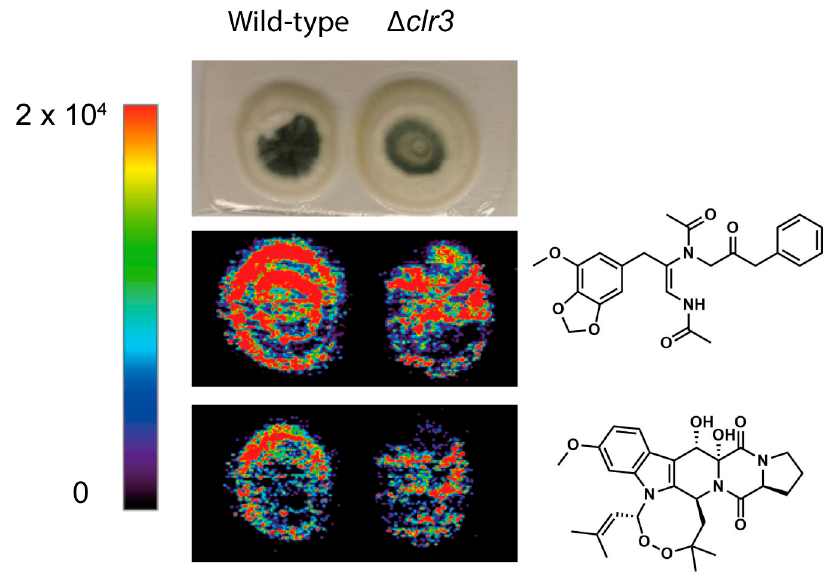
Figure 9. (+) DESI-MSI showing different spatial distributions and concentrations of brasiliamide A and verruculogen on fungal surface. Images are plotted on the same color scale from 0 (black) to 2 × 10 4 (red); ion concentration cannot be compared across images due to ionization differences between molecules.